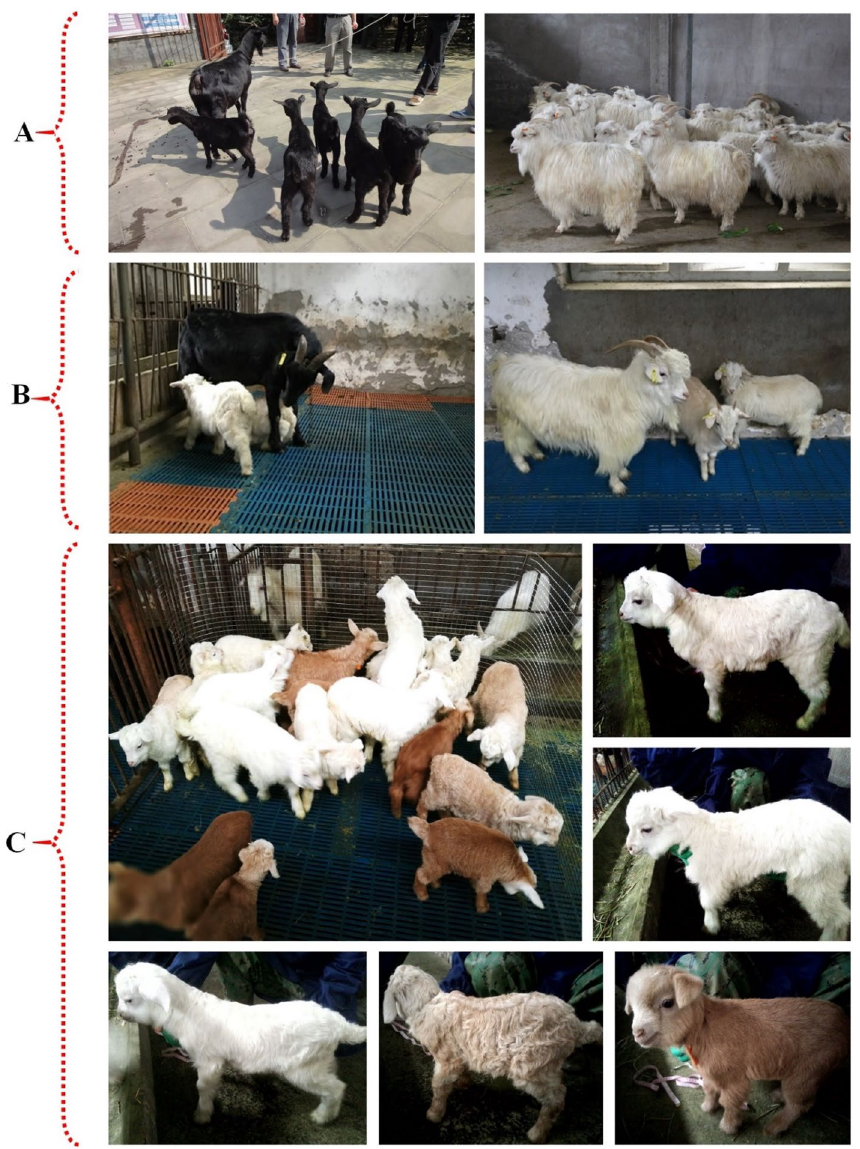
Figure 7. ( A ) The both pure breeds; Inner Mongolia Cashmere goat (IMCG) and Dazu Black goat (DBG), and their progeny (inbreeding). ( B , C ) The results of crossing between IMCG and DBG, and the light coat colour (off white to light-brown) for all the progeny (F 1 ).